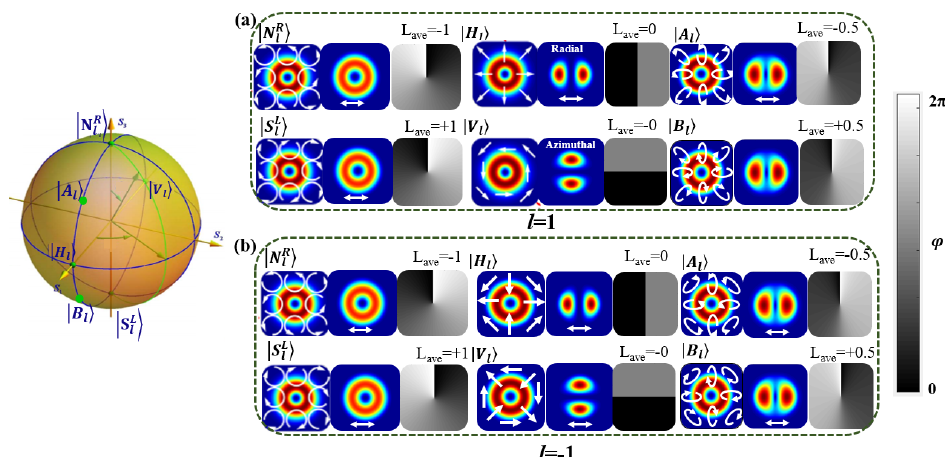
Figure 3. ( a ) Intensity profiles, polarization states and phase distributions of superimposed modes when l = 1 and ( b ) l = − 1. The north pole N (cid:3039)(cid:2902) and south pole S (cid:3039)(cid:2896) represent orthogonal circularly-polarized modes with topological charges of − l and + l ; The points H l and V l represent the two points on the equator; The A l and B l points represent the two modes with − 0.5 and 0.5 average OAM values, respectively.